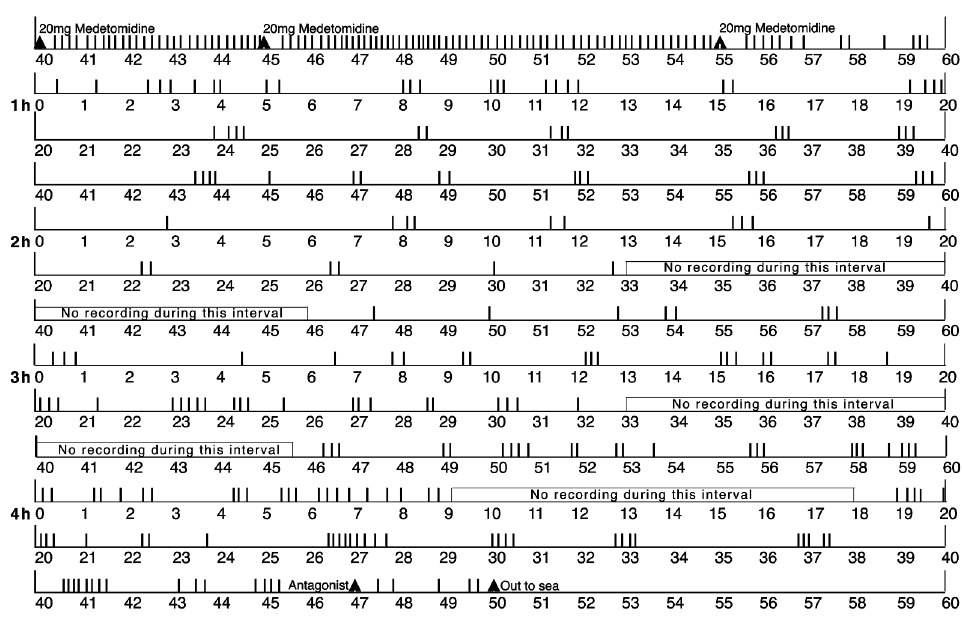
Fig. 1 . Breathing rate of an adult male walrus (no. 6) during immobilisation with medetomi- dine following an initial immobilisation with etorphine/diprenorphine. Time (min) is given rel- ative to darting with etorphine (i.e. the first dose of medetomidine was injected 40 min after darting). The breathing rate was greatly reduced after the third medetomidine injection, and after a further 0.5 h was transformed into a more intermittent pattern with several breaths at intervals of several